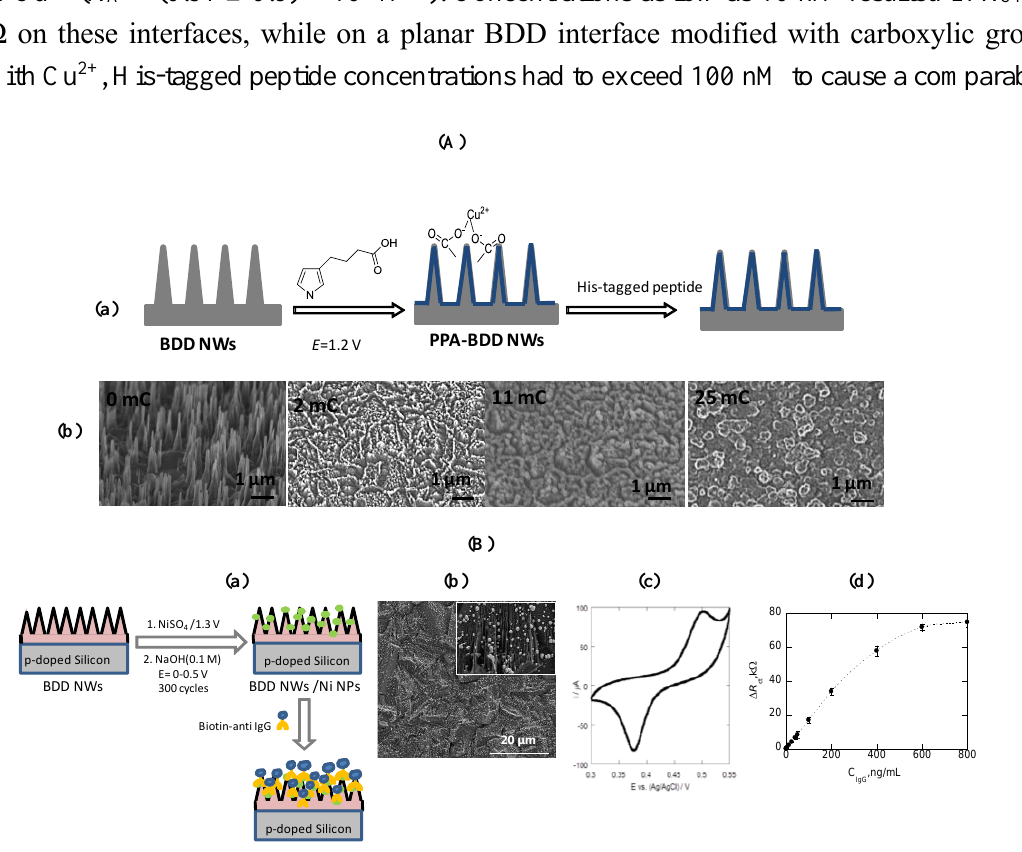
Figure 10. Diamond nanowires for immunosensing. ( A ) ( a ) fabrication method of polymer coated BDD NWs (PPA BDD NWs) with chelated Cu 2+ ions and subsequently modified with histidine-terminated target; ( b ) SEM images of BDD NWs after electrochemical deposition of carboxylic acid-terminated poly(pyrrole) (100 mM) in TBATFB (0.1 M)/ acetonitrile solution at E = +1.2 V for different deposition charges (2, 11, 23 mC·cm −2 ) (reprint with permission from [39]); ( B ) Fabrication method of Ni NPs modified diamond nanowires ( a ), SEM image of Ni NPs modified diamond nanowires ( b ), CV of Ni NPs-BDD NWs in 0.1 M NaOH ( c ), Calibration curve for IgG ( d ) (reprint with permission from